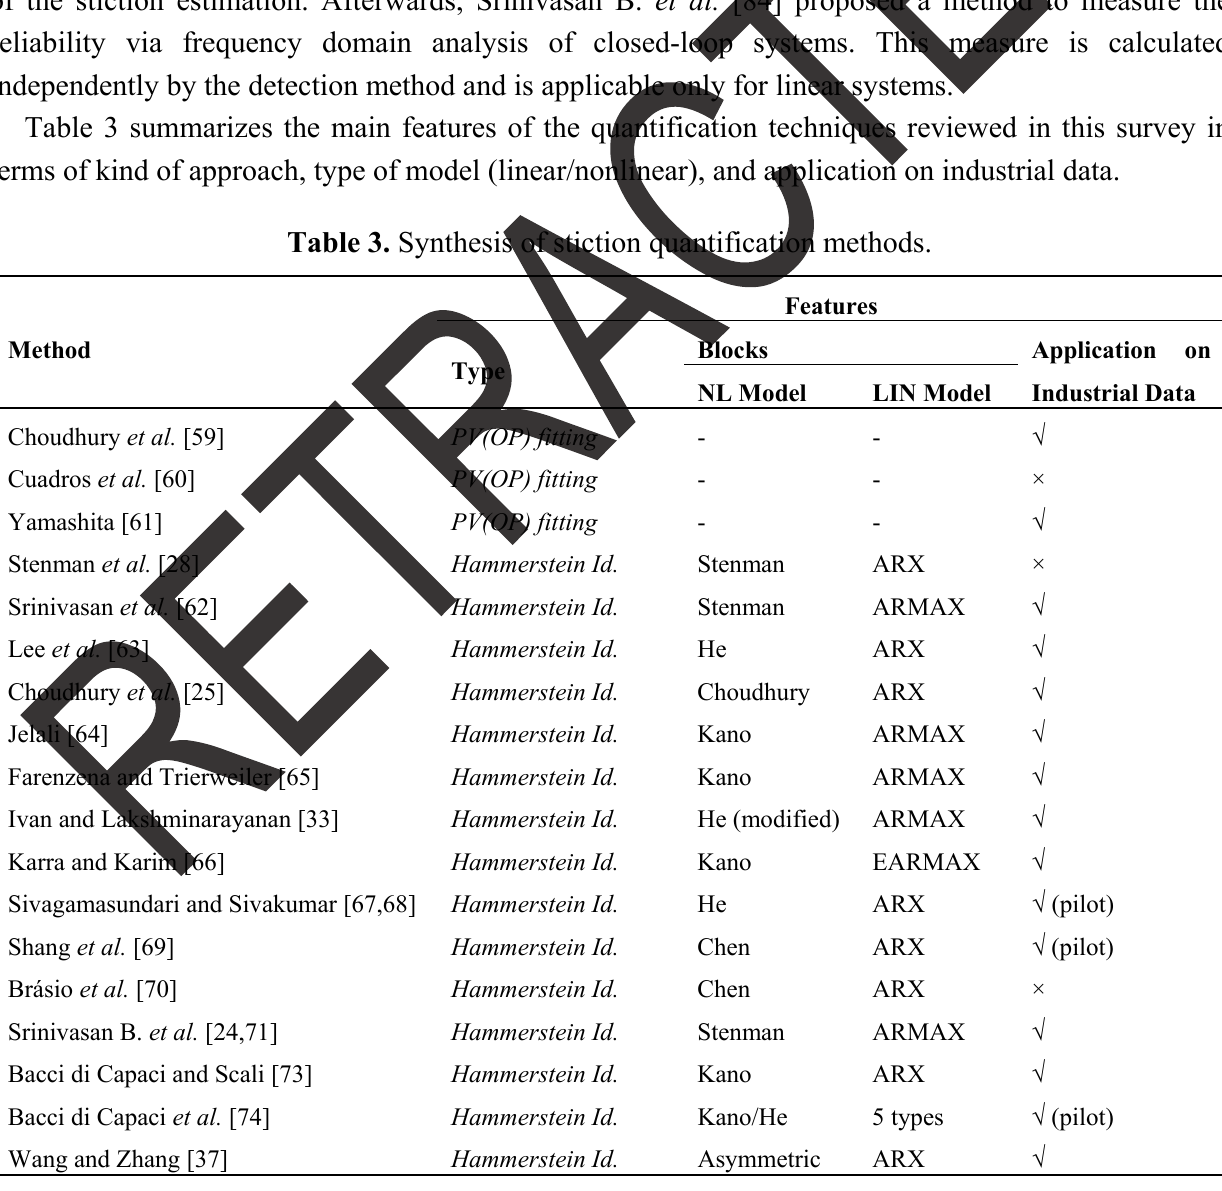
Table 3. Synthesis of stiction quantification